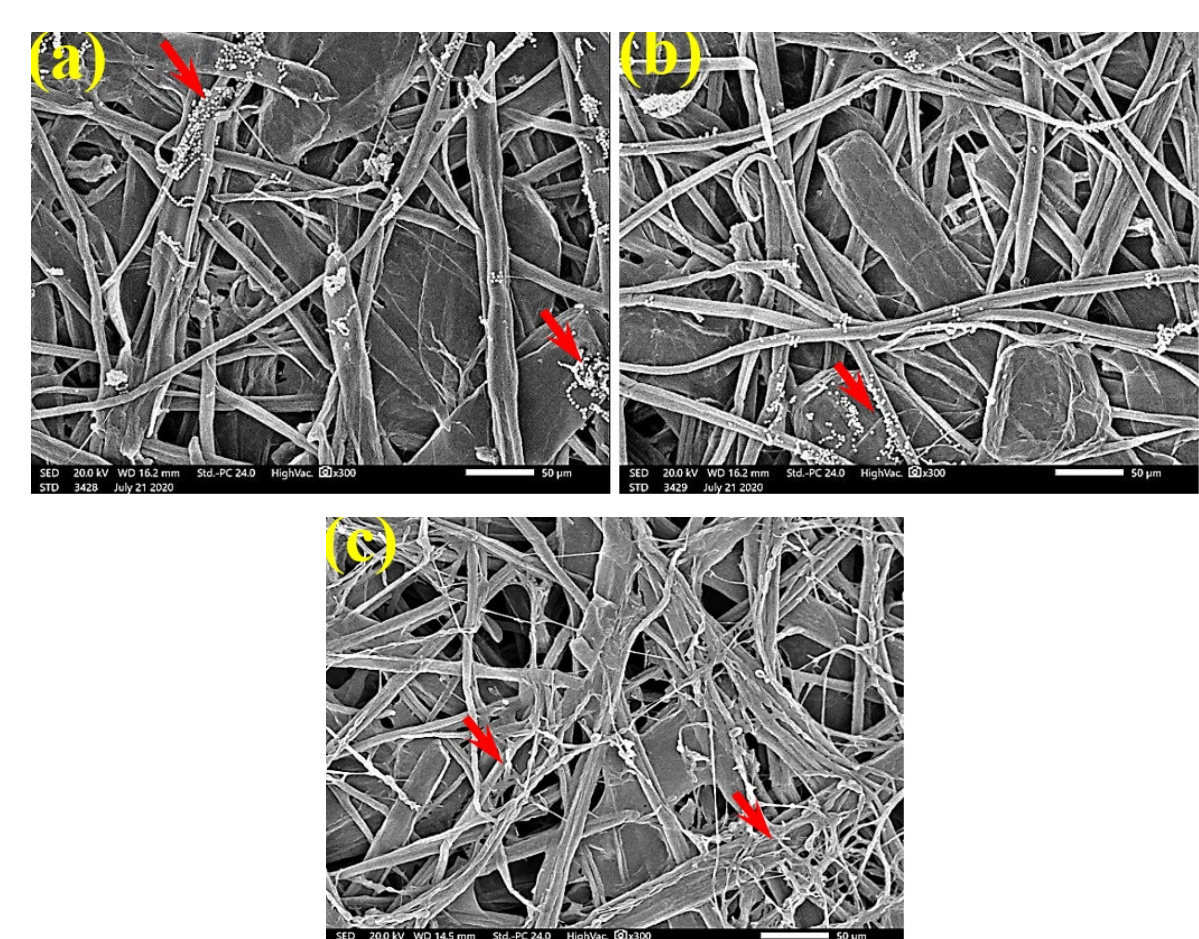
Figure 7. SEM images of paper sheets manufactured from pulps of ( a ) B. speclabilis , ( b ) F. altissima , and ( c ) F. elastica treated with 0.25% MAHE and inoculated with A. fumigatus . Arrows refer to dense growth of fungal mycelia based on the con- centration of the extract and the type of paper sheet pulp.